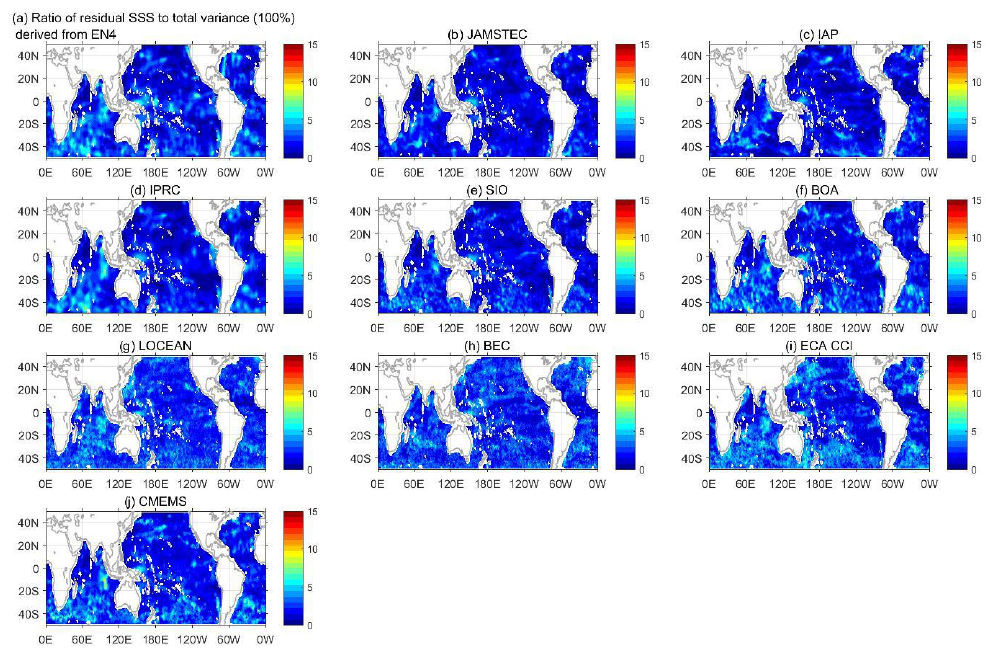
Figure A5. The ratio of residual SSS variance to the total SSS variance in ten products. The residual SSS is derived from the subtraction of the original SSS signal from the sum of sub-annual, annual and interannual SSS time series. The units are %.